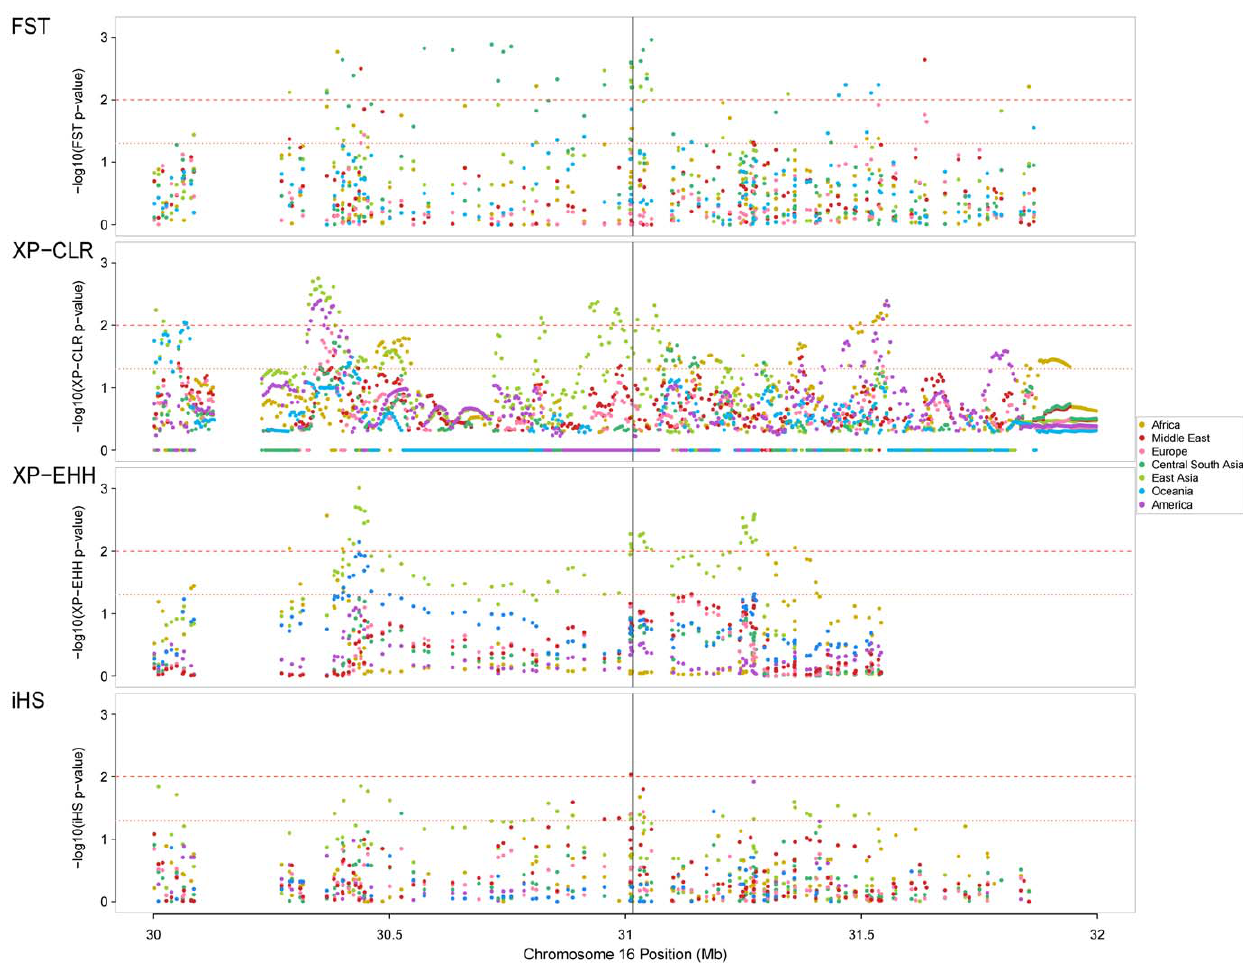
Figure 3. Distribution of –log 10 ( p- values) for four selection tests across a 2 Mb region centered on VKORC1 . A black vertical line indicates the physical position of VKORC1 on chromosome 16. Horizontal red dotted and dashed lines show 0.05 and 0.01 chromosome-wide significance levels, respectively. The selection tests (inter-regional F ST , XP-CLR, XP-EHH and iHS, respectively) were separately applied in each of the seven geographic